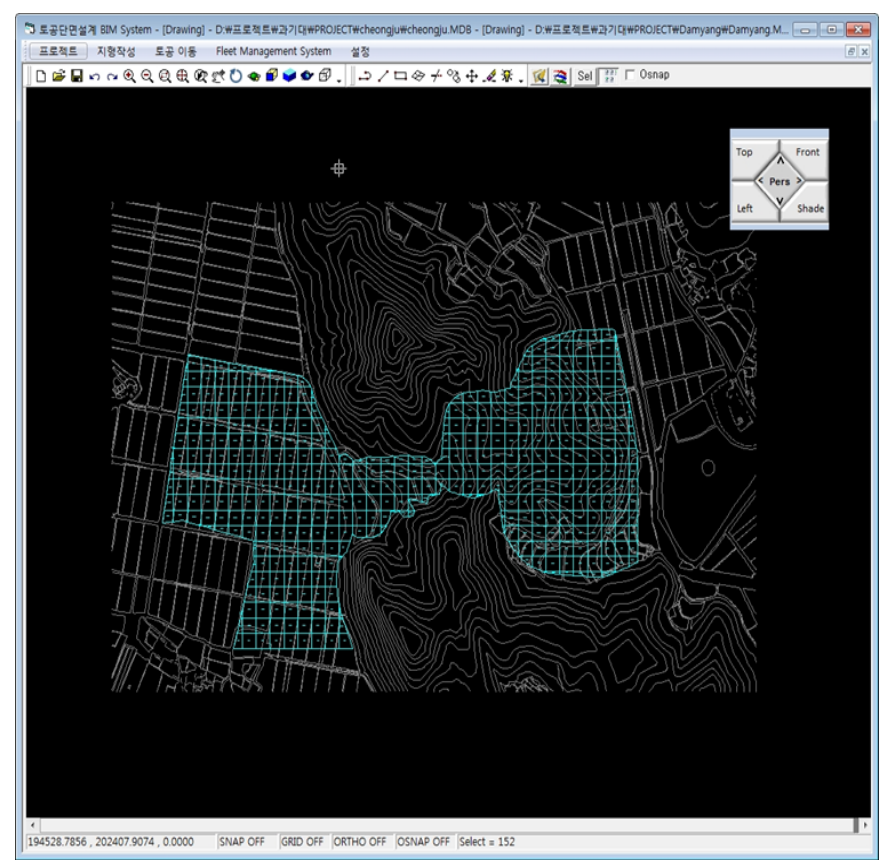
Figure 6. Terrain Modeling with Prohibited Zones.